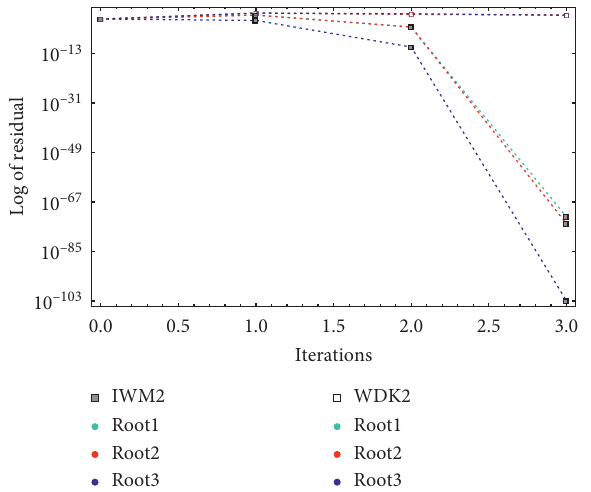
Figure 7: Error graph of WDK2 and IWM2 for f